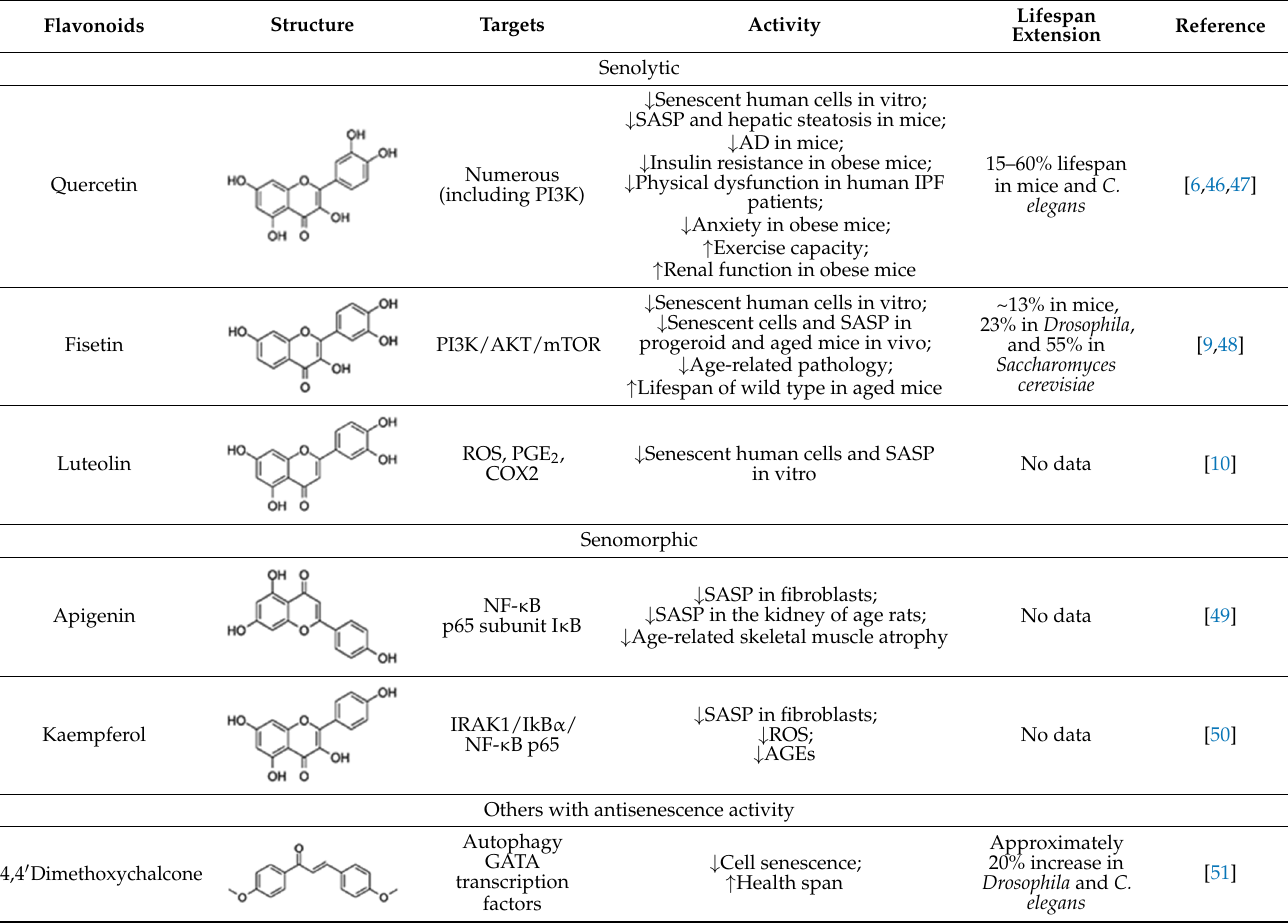
Table 1. Overview of the modulatory anti-aging effect of flavonoids and related mechanisms. Flavonoids